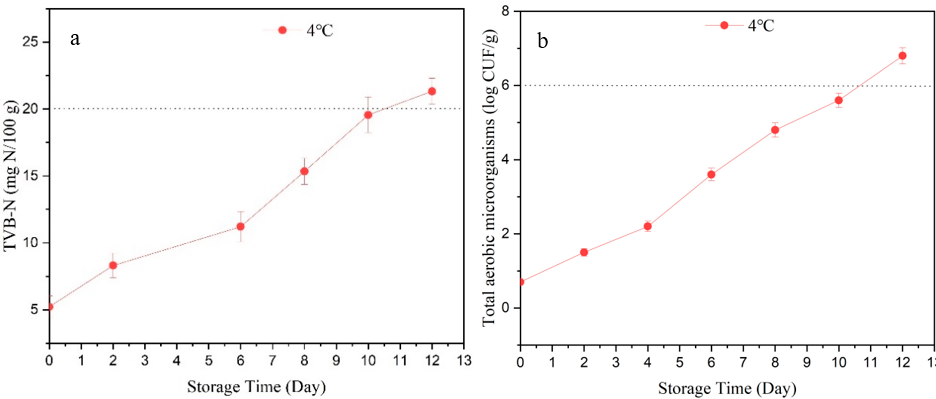
Figure 1. The TVB-N ( a ) and count of aerobic microorganisms ( b ) of crawfish at 4 °C in vacuum packaging.